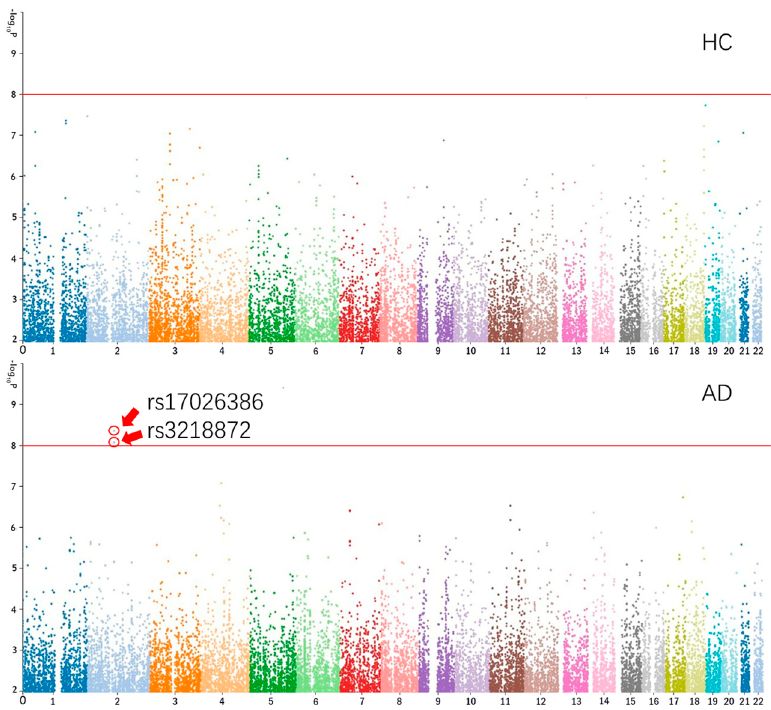
Figure 1. The Manhattan plots of CA1 of HC and AD. CA1 = cornu ammonis 1 region; HC = healthy control; AD = Alzheimer's disease.